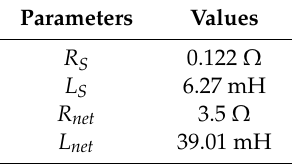
Figure 14. Experimental system of the TCL-CTF. Table 4. The impedance parameter of an equivalent system and simplified traction network.